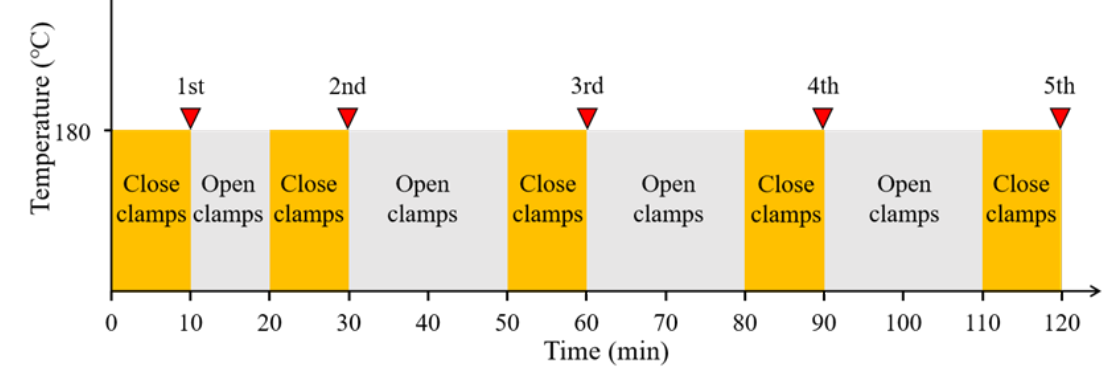
Figure 2. Operation process for Method 2 (sampling five times).